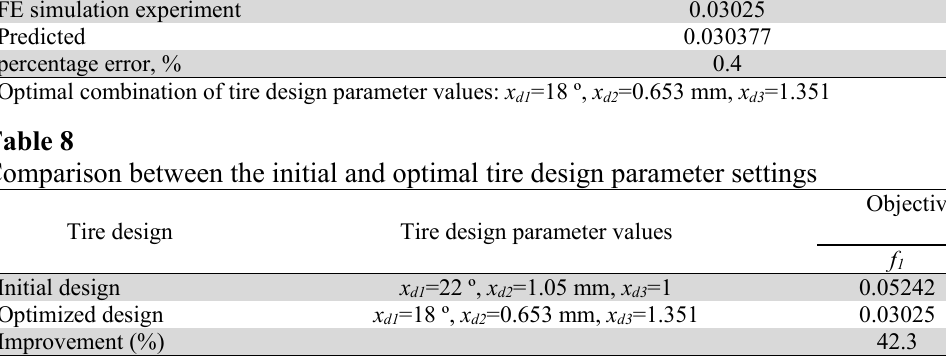
Result of validation FE experimental trial FE simulation experiment